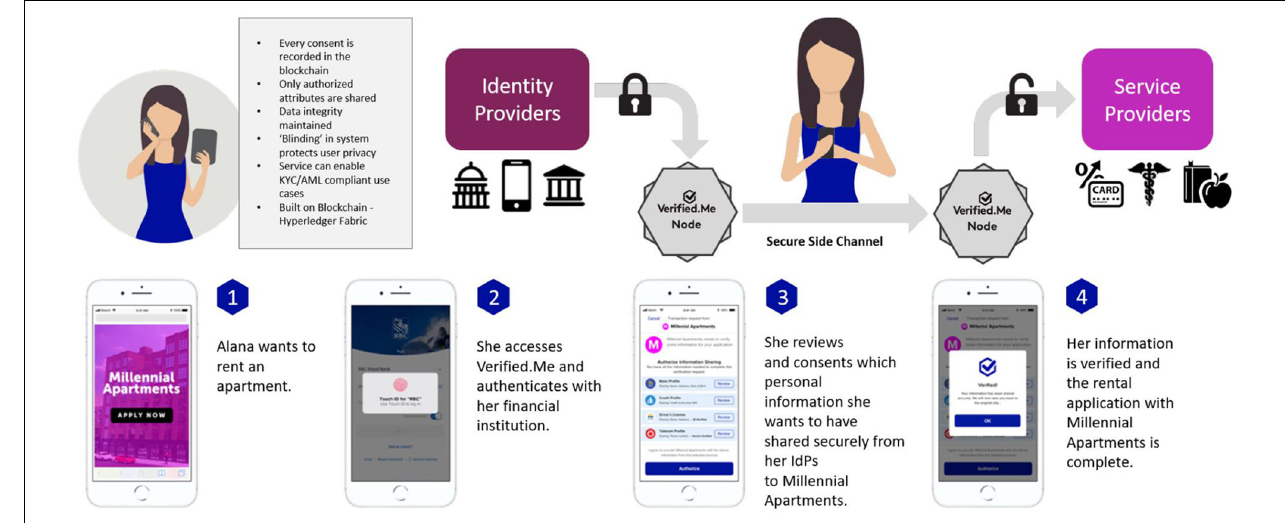
FIGURE 1 | A use case example of Verified.Me to verify identities for a rental